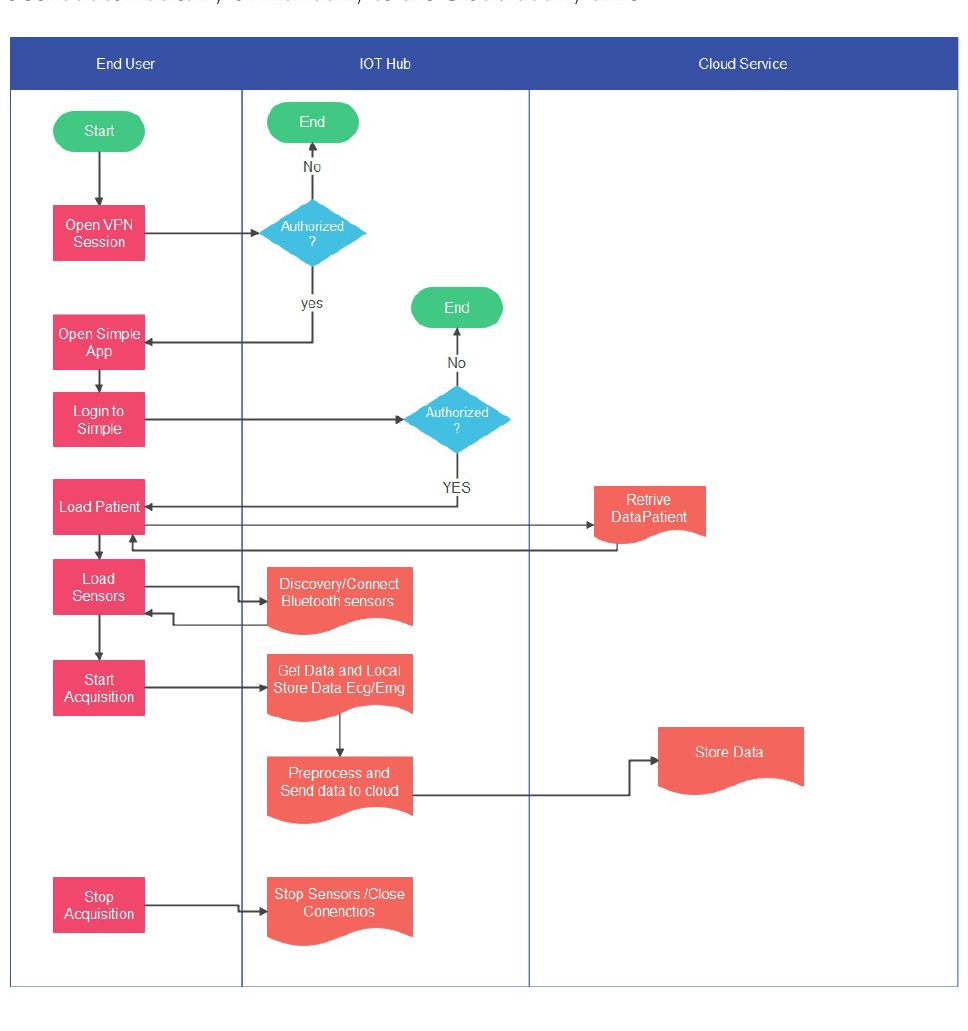
Figure 5. Flow chart relative to the communication between SIMpLE